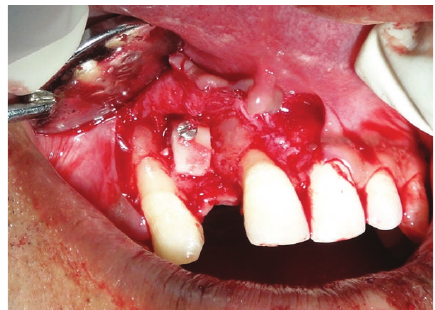
Figure 8: Block graft fixed at the recipient